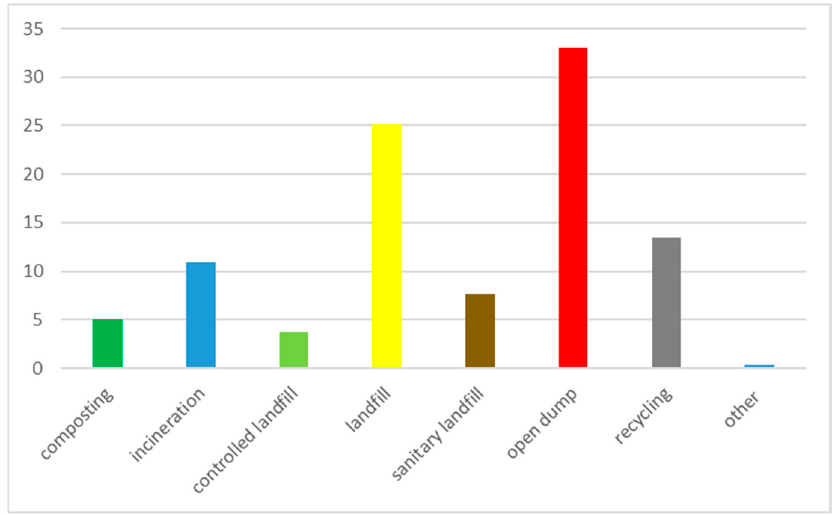
Figure 8. Global treatment and disposal of waste (%)